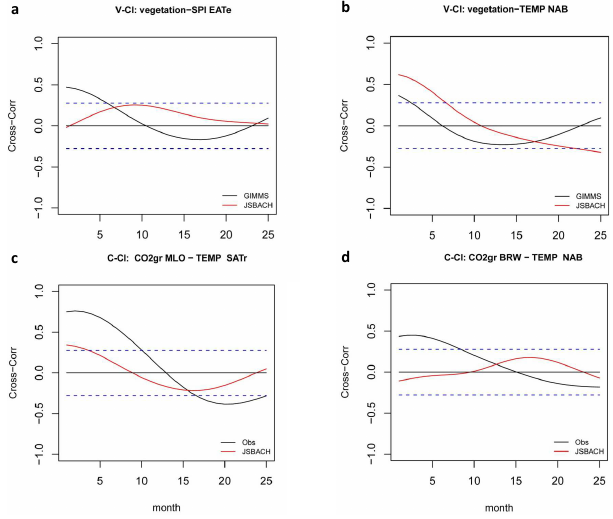
Fig. 9. (a) Cross correlation between precipitation pattern (SPI) and vegetation activity in Eurasia Temperate (EATe). (b) Cross correla- tion between temperature and vegetation activity in North Ameri- can Boreal (NAB). (c) Atmospheric CO 2 growth rate in the station of Mauna Loa (MLO) and temperature pattern in the South Amer- ican Tropical (SATr). (d) Atmospheric CO 2 growth rate in Barrow (BRW) and temperature patter in NAB. Dotted lines are confidence intervals at significant level of P < 0 . 05 (two-tailed